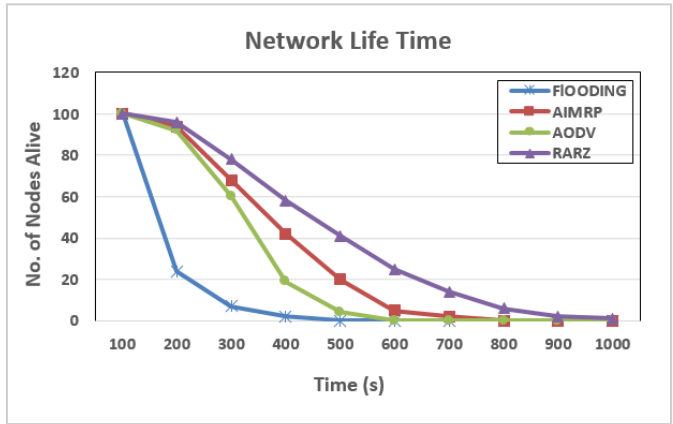
Figure 8. Number of nodes alive over time.